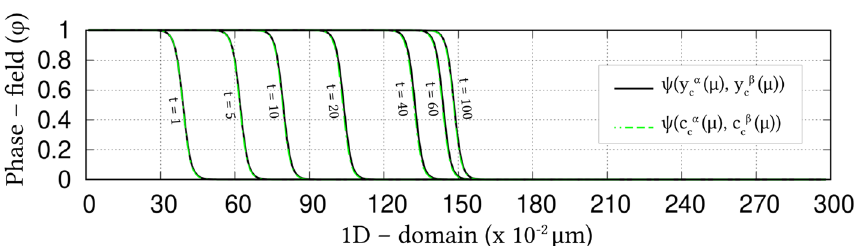
Figure 5. Spatio-temporal evolution of phase-field reflecting the growth of ferrite, in one-dimensional domain, governed by the site-fraction based driving force, which is incorporated through the coefficients in Table 1. Transformation rendered by the conventional mole-fraction based formulation ( ψ( c α C (µ) , c coefficients in Table 2, is included for comparison.